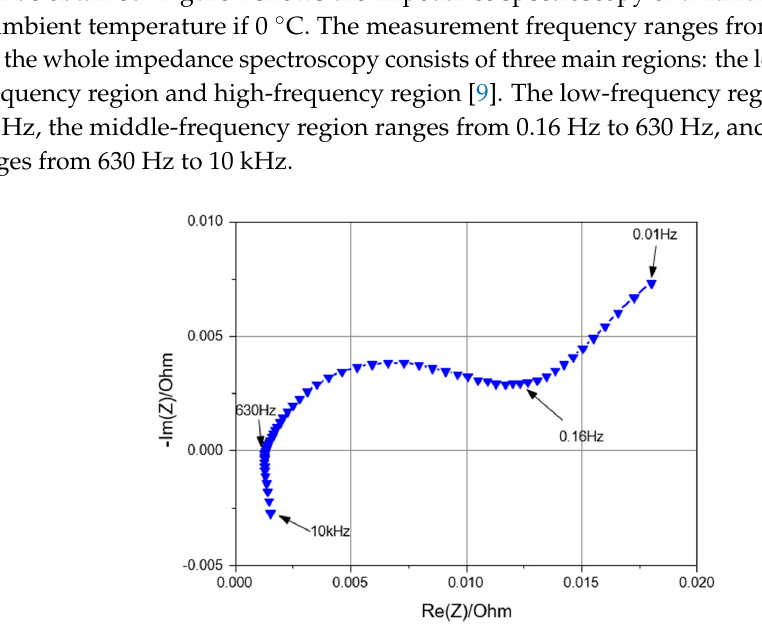
Figure 1. Impedance spectroscopy of a battery at 50%, 0 °C.